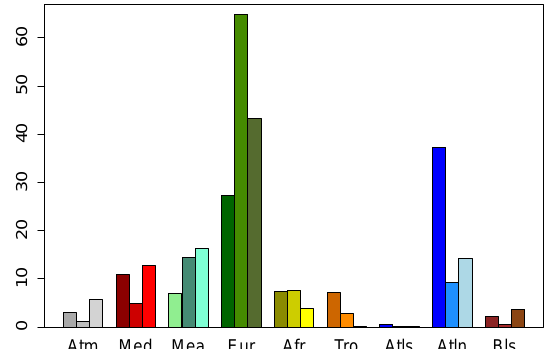
Figure 10. Relative contribution of the different moisture sources to the precipitation in the target region between 00:00UTC on 15 May and 00:00UTC on 18 May 2010 (in %). Three bars are shown for each moisture source, the left one representing the COSMO tag- ging simulation with parameterisation Evap_tot, the middle one the COSMO tagging simulation with parameterisation Evap_tag and the right one the Lagrangian